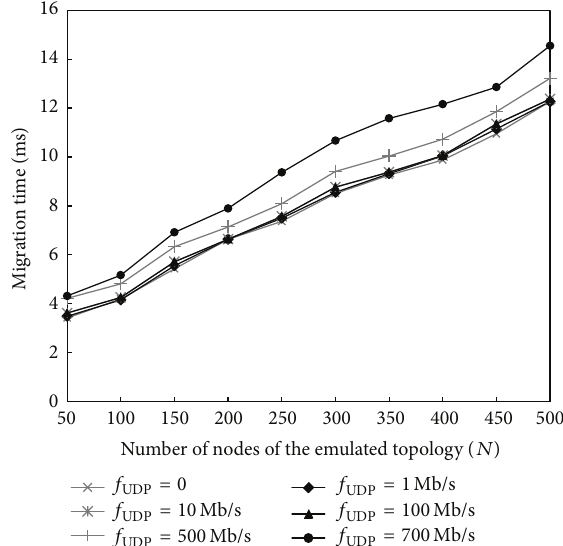
Figure 14: Migration time components as a function of the number 𝑁 of nodes in the emulated network. The UDP traffic rate 𝑓 equal to zero.